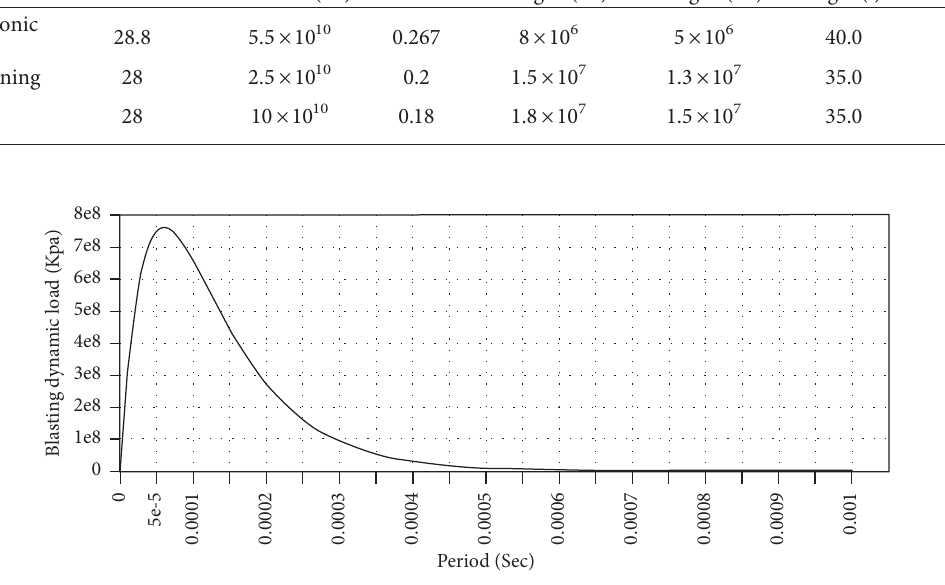
Figure 10: Time history curve of blasting dynamic load.